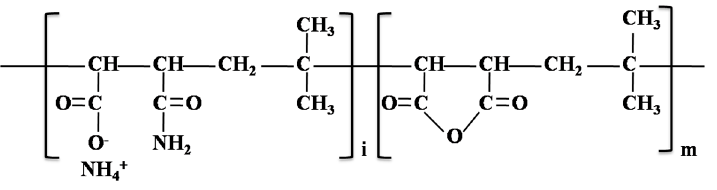
Figure 9. The chemical structure of ISOBAM ‐ 104